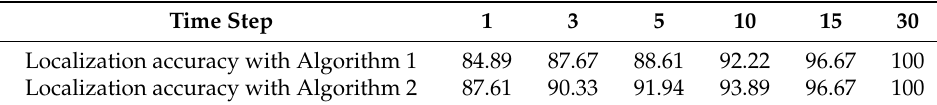
Table 6. Results of two algorithms ( T A = 1 s; E = 4 dB; RSSI index = m - RSSI index). Time Step Localization accuracy with Algorithm